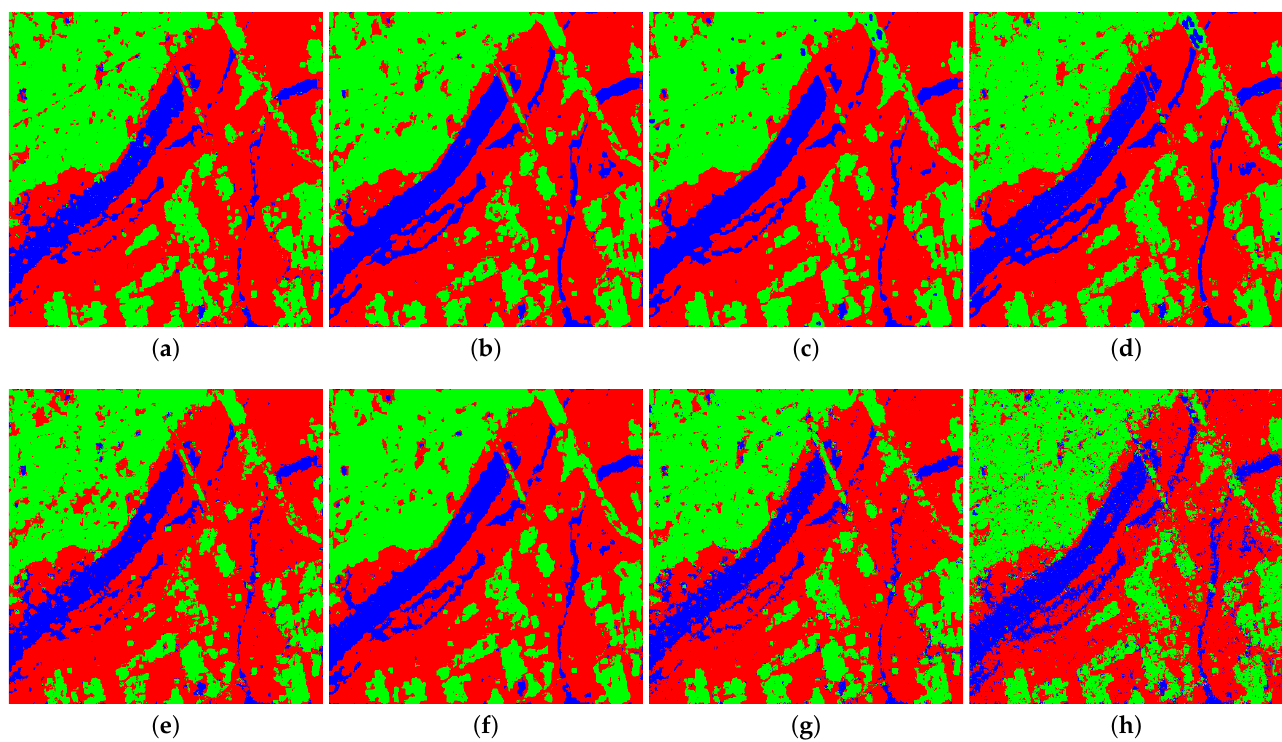
Figure 10. Prediction result of Xi’an area obtained by different methods, including ( a ) SVM on the learned parameters, ( b ) SVM on all the parameters, ( c ) ANN on the learned parameters, ( d ) ANN on all the parameters, ( e ) AE on the learned parameters, ( f ) AE on all the parameters, ( g ) AEFT on the learned parameters, and ( h ) AEFT on all the